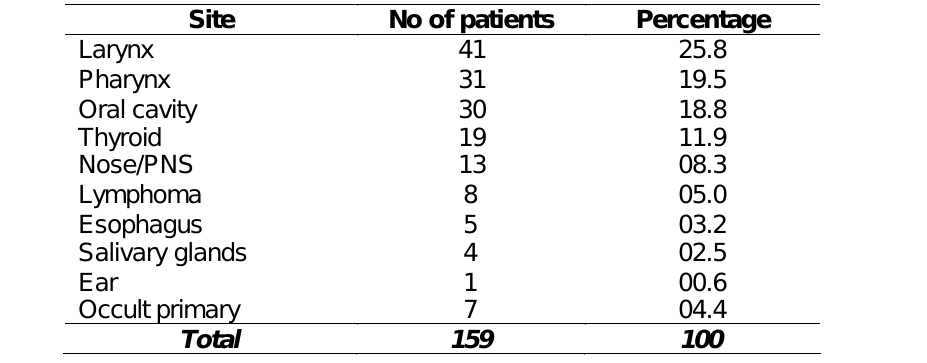
Table I : Distribution of